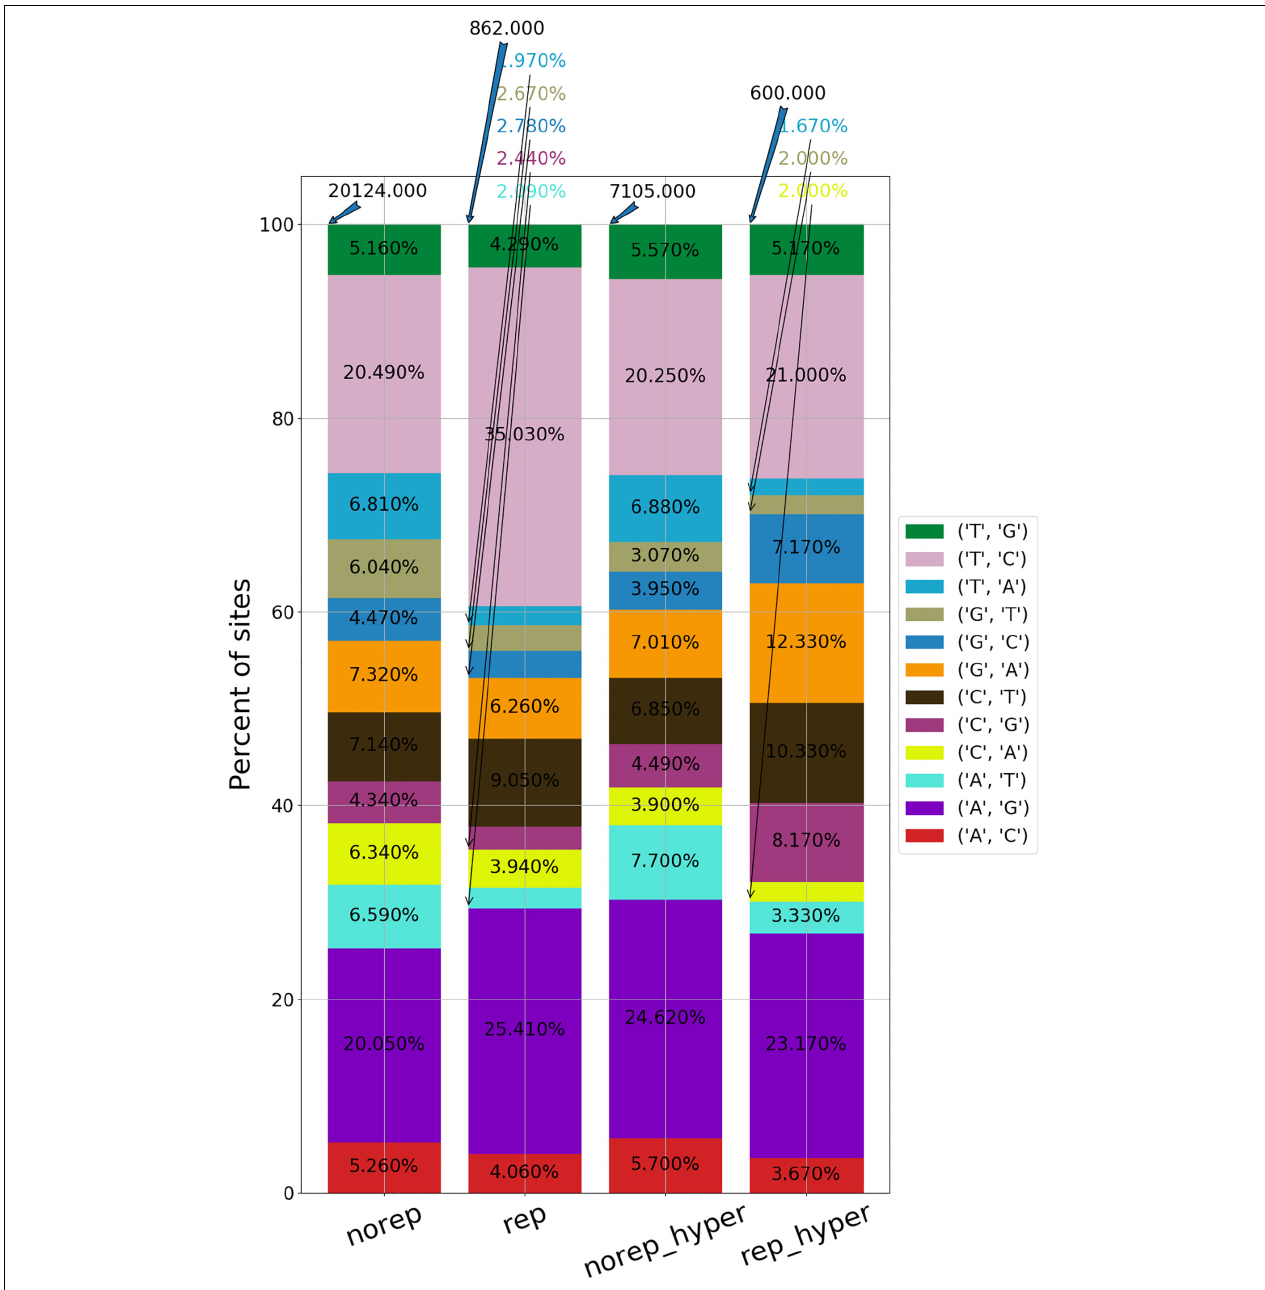
FIGURE 2 | An example for RESIC editing percent distribution plot, obtained for an adrenal tissue sample. Blue arrow at the top of each bar shows the total number of sites being identified for the class. The percentages on the bars present the total number of editing type out of all identified site in the class. The x-axis labels represent the RNA editing classes. Norep: non-repetitive, rep: repetitive, norep_hyper: non-repetitive hyper, rep_hyper: repetitive hyper.